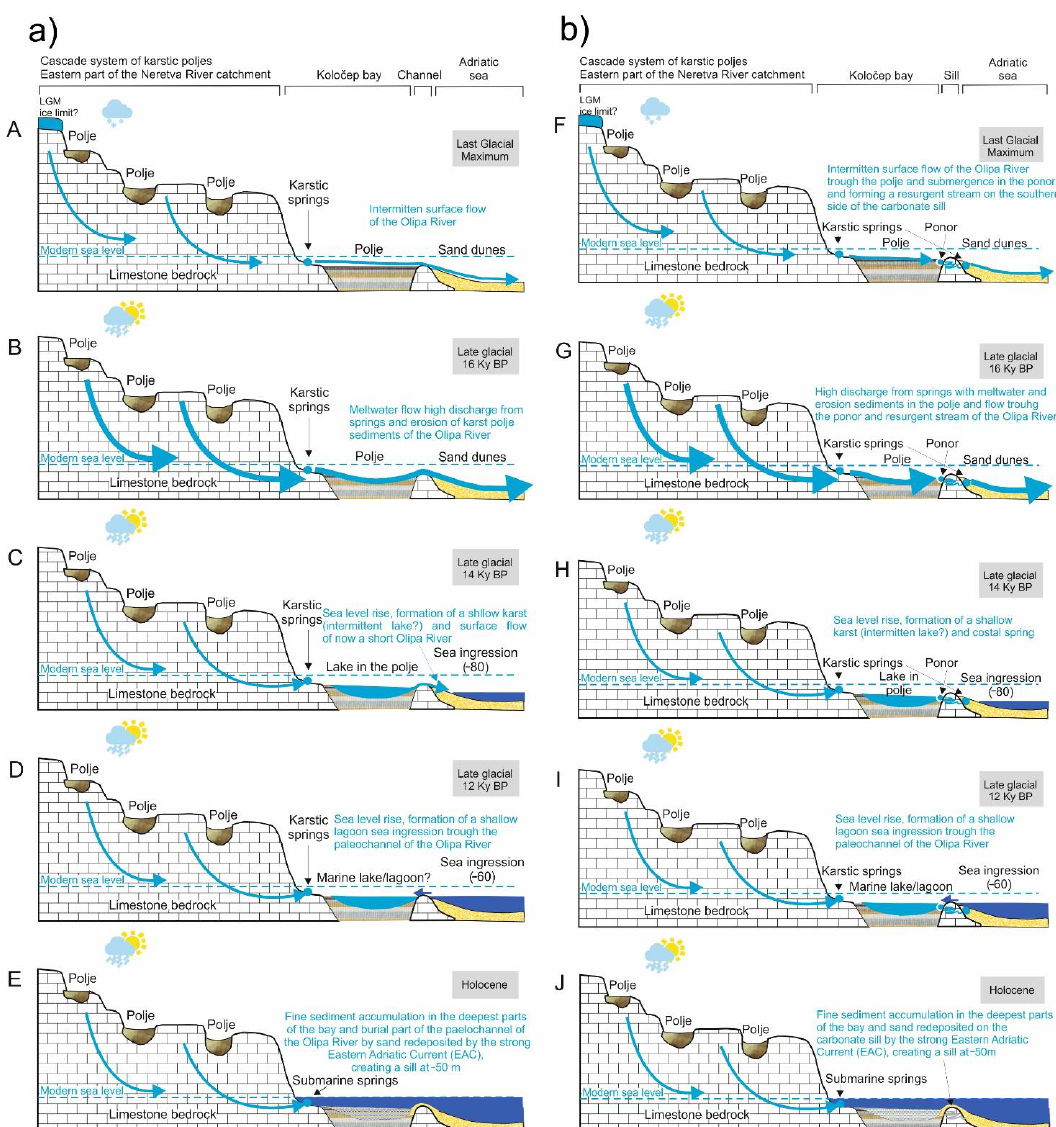
Figure 18. Cascade system of karstic poljes with two possible scenarios in relation to RSL from LGM to the Holocene, considering ( a ): open channel area with the intermittent surface flow of Olipa River during LGM ( A ); Late Glacial rivers with high discharge from springs erode sediment from the karst poljes ( B ); formation of a shallow karst lake with short surface flow of the Olipa River and rising sea level ( C ); sea level rise with ingression through the paleochannel of Olipa River, and the formation of shallow lagoons ( D ); fine sediment accumulation during the Holocene in the deepest parts of the bay and the burial part of the paleochannel of the Olipa River by sand redeposited by strong eastern Adriatic currents creating a sill at − 50 m ( E ); ( b ) intermittent surface flow of the Olipa River through the karst poljes and submergence in the ponor, forming a resurgent stream on the southern side of the carbonate sill during LGM under the influence of tectonic activity ( F ); high discharge from springs and erosion of sediment in the poljes and flow through the ponor and resurgent streams of the Olipa River during the Late Glacial period ( G ); formation of a shallow karst lake with short surface flow of the Olipa River with the formation of costal springs and rising sea level ( H ); sea level rise with ingression through the paleochannel of Olipa River and the formation of a shallow lagoon ( I ); fine sediment accumulation in the deepest parts of the bay and burial in parts of the paleochannel of the Olipa River by sand redeposited on the carbonate sill by strong eastern Adriatic currents creating a sill at − 50 m during the Holocene ( J